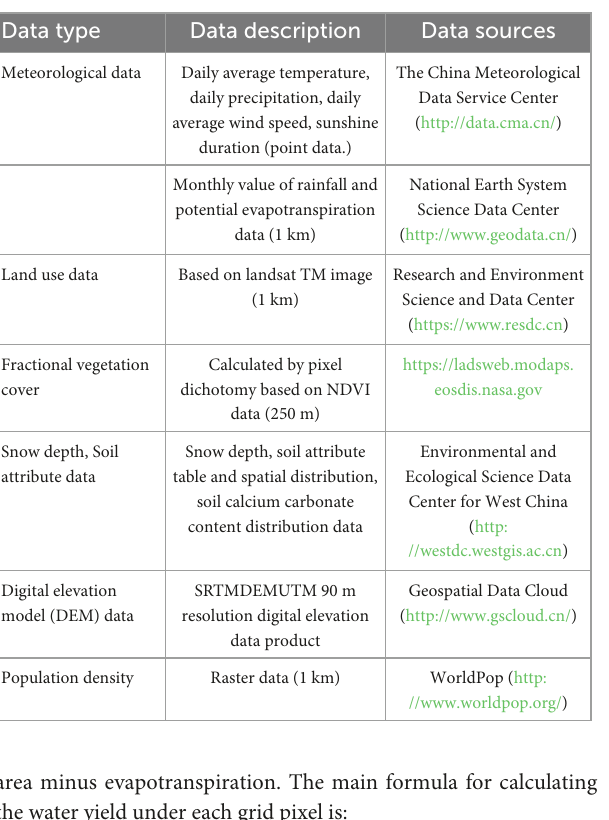
TABLE 1 Study data